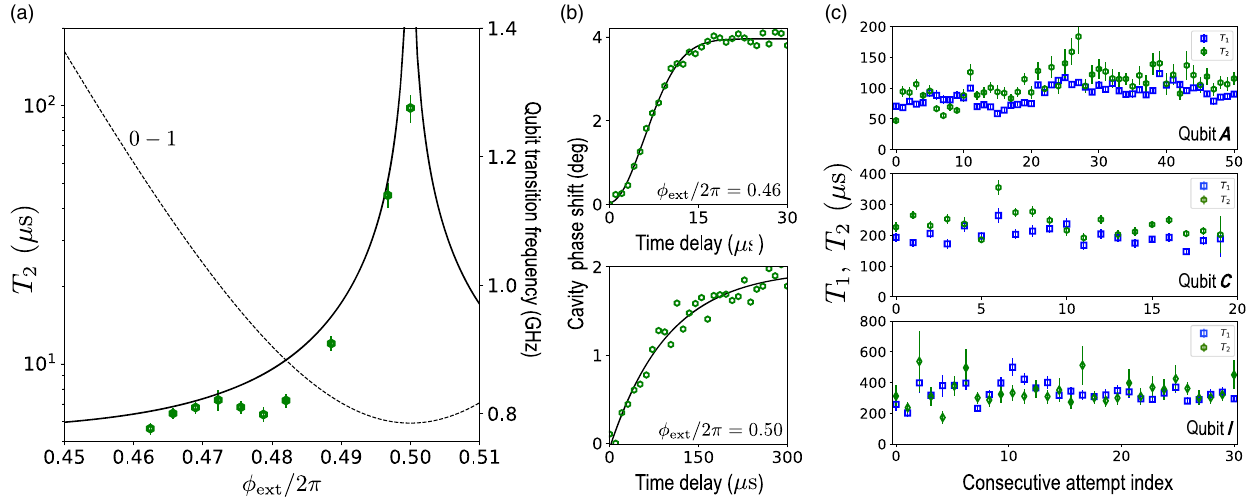
FIG. 4. (a) Coherence time T 2 (markers) and the qubit frequency (dashed line) as a function of the flux. Solid line indicates a prediction for the first-order coupling to a 1 =f flux noise. (b) Gaussian echo signal away from the sweet spot (top) and an exponential echo signal at the sweet spot (bottom). (c) Interleaved measurement of temporal fluctuations of T 1 (blue markers) and T 2 (green ¼ π over a time interval of approximately 12 markers) at ϕ ext